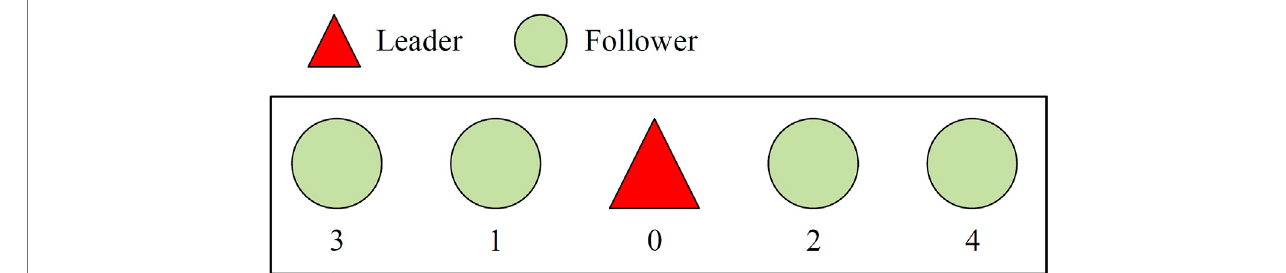
FIGURE 4 | Parallel formation